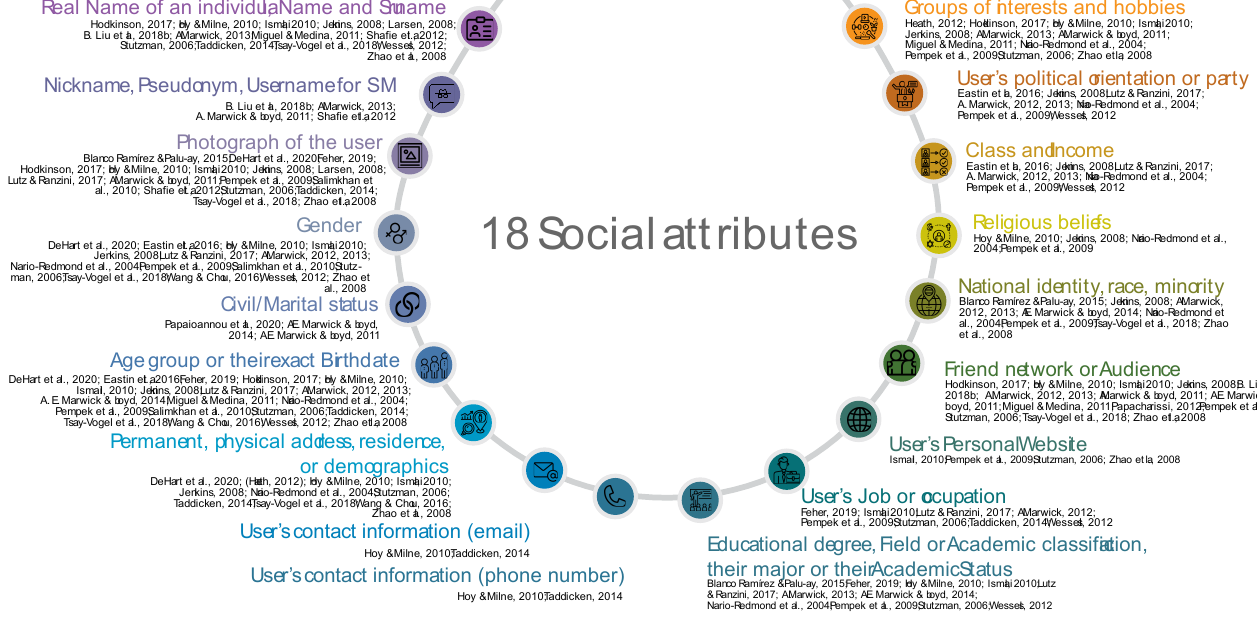
Figure 2. User’s Social Attributes on Social Media. Figure 2. User’ s Social Attributes on Social Media. Figure 2. User’ s Social Attributes on Social Media.